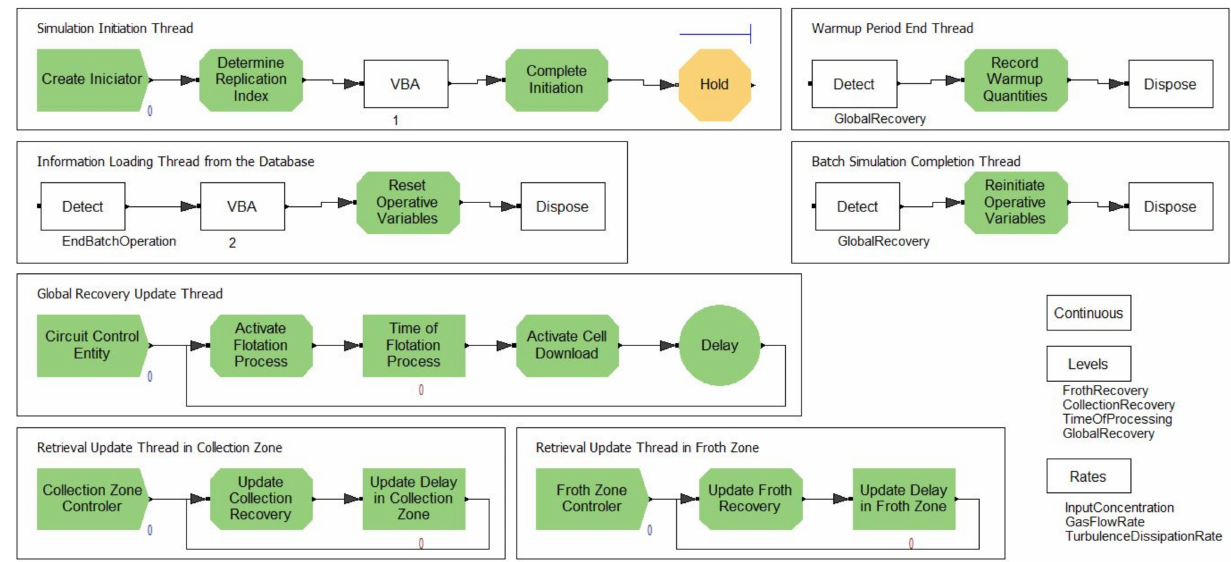
Figure 2. High-level diagram of the rougher cell in Arena (version